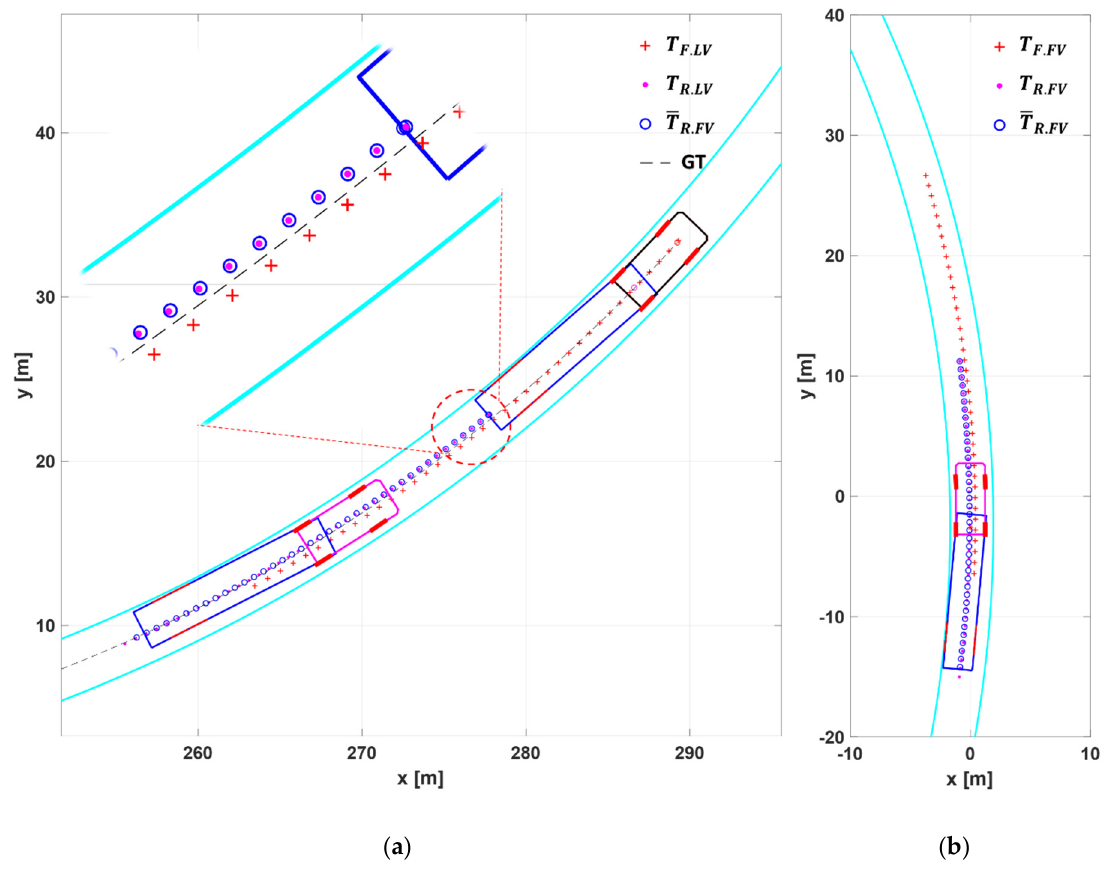
Figure 18. The simulation results for Scenario S1 ( a ) 𝑇 (cid:3007).(cid:3013)(cid:3023) , 𝑇 (cid:3019).(cid:3013)(cid:3023) , and 𝑇(cid:3364) (cid:3019).(cid:3007)(cid:3023) in LV and FV; ( b ) 𝑇 (cid:3007).(cid:3007)(cid:3023) , 𝑇 (cid:3019).(cid:3007)(cid:3023) and 𝑇(cid:3364) (cid:3019).(cid:3007)(cid:3023) in FV. The black dash is the actual travel path (GT) of the front trajectory of LV. The cyan line next to the vehicles means the left/right